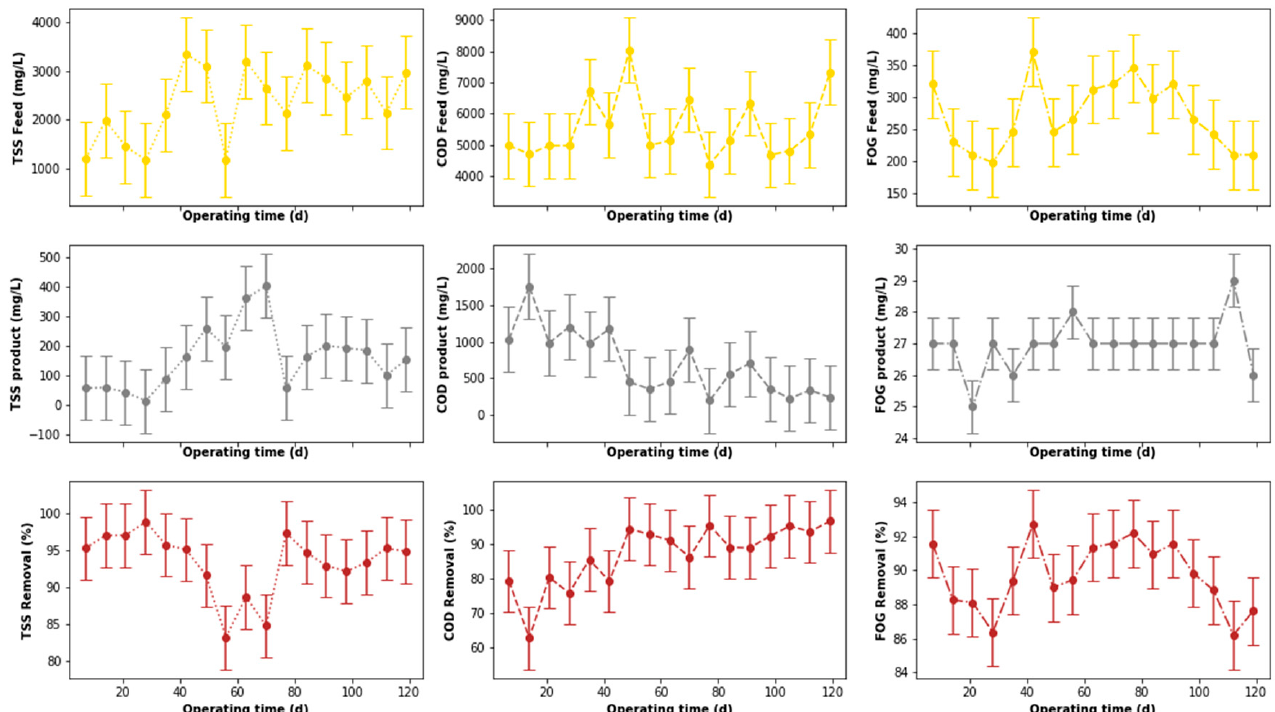
Figure 13. Boxplots of the DEGBR highlighted features before and after outliers’ replacement: ( a ) Boxplots before outliers’ replacement; ( b ) boxplots after outliers’ replacement